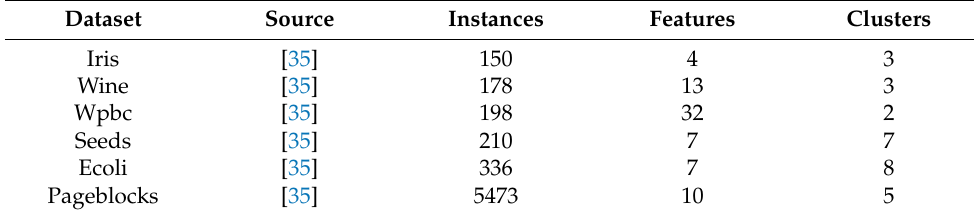
Table 4. Information of the real-world